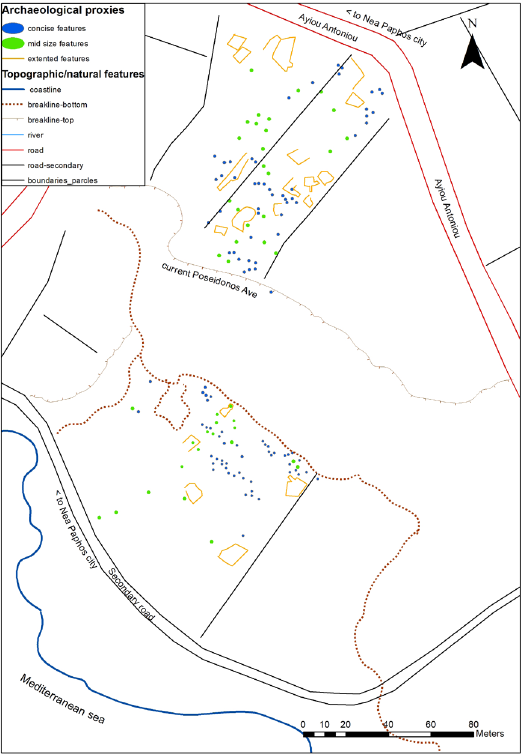
Figure 5: Map showing areas with the main concentrations of archaeological proxies (after authors’ interpretation based on 1968 aerial photograph), and the most significant topographic and natural features (after authors’ digitisation of the 1968 aerial photograph, also in conjunction with related cadastral maps) of the Eastern necropolis of Nea